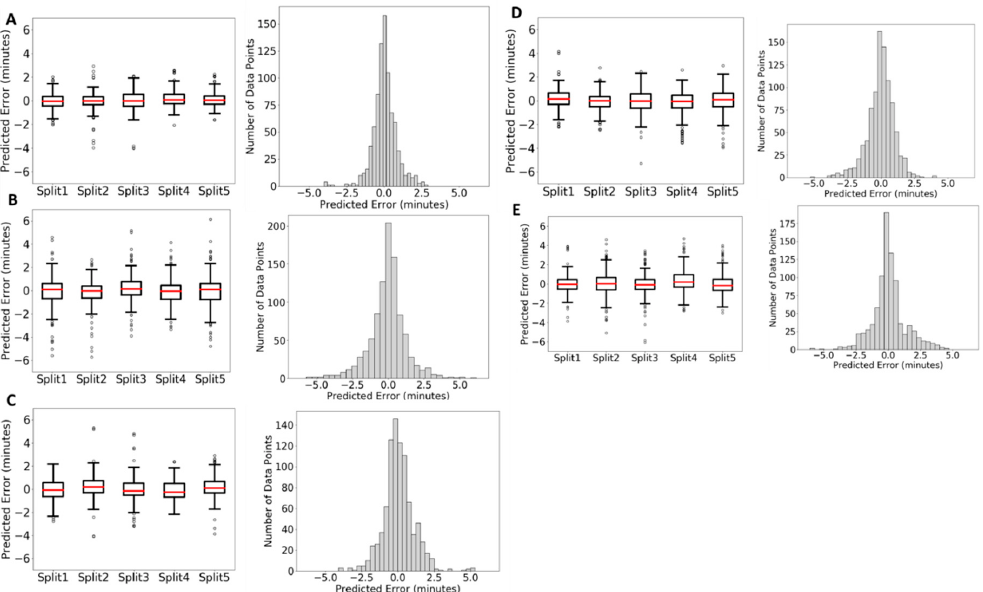
Figure 4. Analysis of error. Each plot has a box plot to show average error of points in separate test/training splits to show consistency and a histogram of all data points to show distribution of error throughout all samples. ( A ). BEH-Amide column, ( B ). CHILIC column, ( C ). HILIC-Z column, ( D ). iHILIC column, ( E ). PHILIC